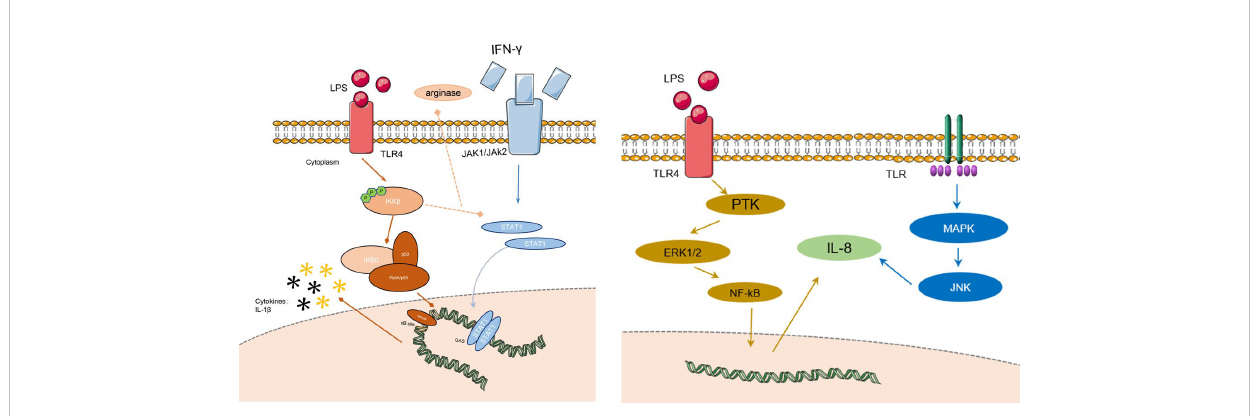
FIGURE 2 The signaling pathways of AZM on RILI. The left fi gure shows the changes of macrophage in action of AZM: the IkB subunit will not be degraded by the phosphorylation of IkKB, and will continue to bind to the NF-kB subunit, preventing the development of downstream pathways, fi nally the process inhibits the release of M1 phenotype in fl ammatory factors, and promotes M1-like phenotype macrophages to M2-like phenotype. The right fi gure shows that IL-8 could be regulated by many signaling pathways like ERK1/2/NF-kB, MAPK, JNK etc. LPS, lipopolysaccharide; IFN-g, interferon- g; TLR, toll-like receptor; MAPK, mitogen-activated protein kinase; JNK, c-Jun N-terminal kinase; IL-8, interleukin; NF-kB, nuclear factor kappa-B; ERK, extracellular regulated protein kinases; PTK, protein tyrosine kinase; JAK, just another